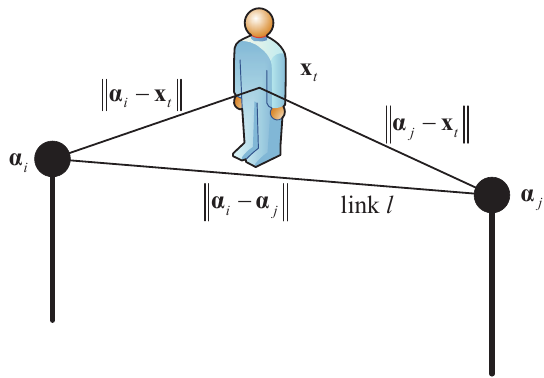
Figure 2. An illustration that a target shadows link l